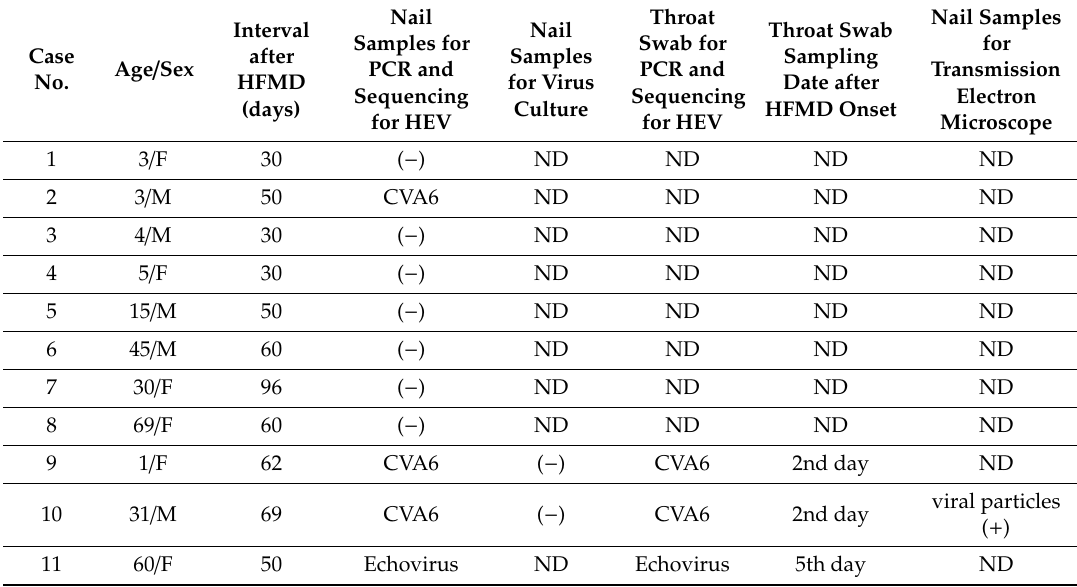
Table 1. Patients with onychomadesis following